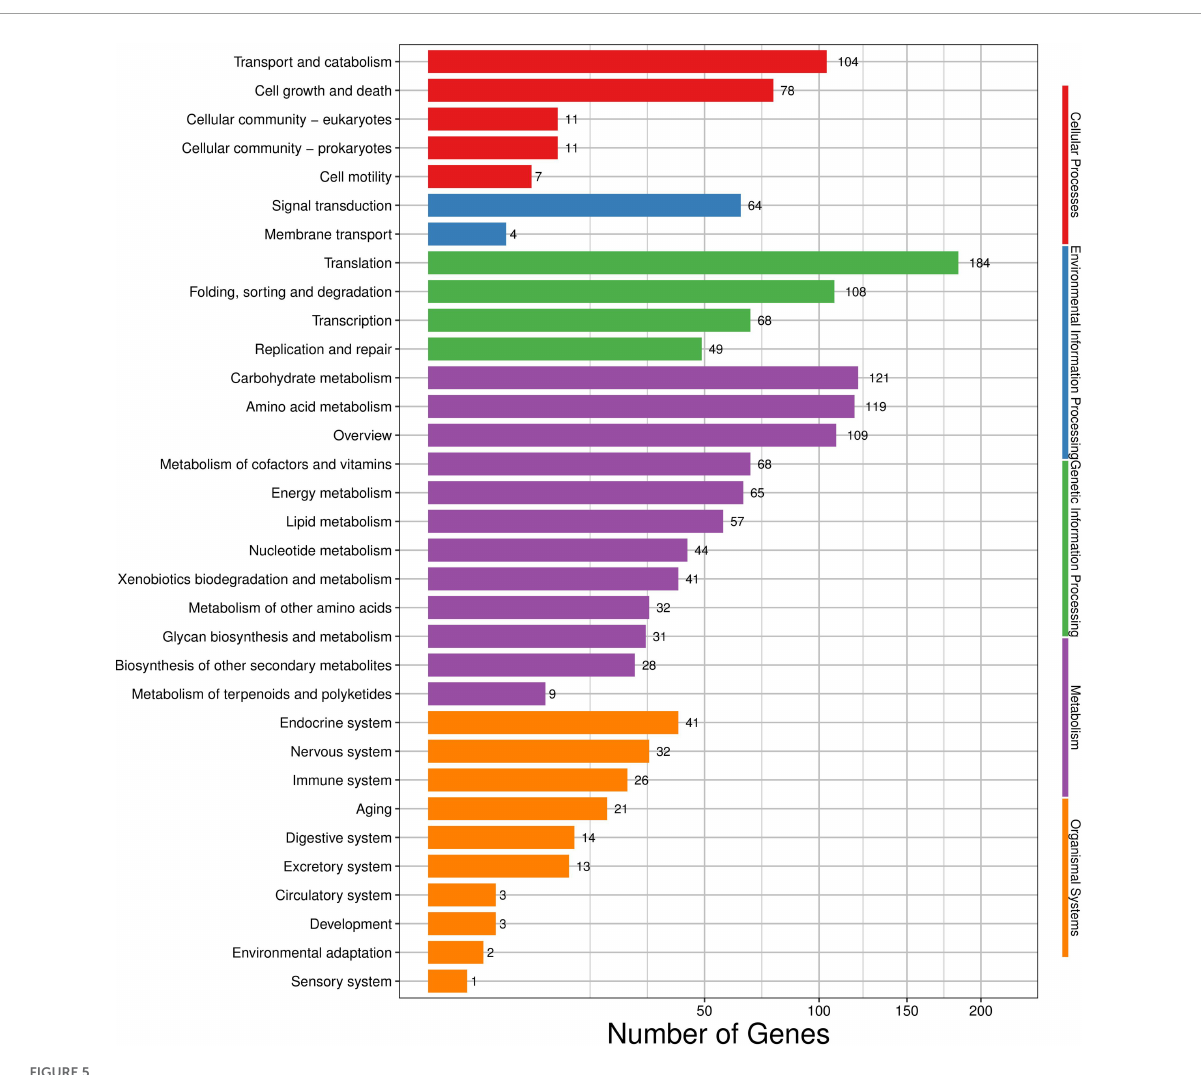
FIGURE5 Kyoto encyclopedia of genes and genomes (KEGG) categories mapped from the annotated proteins. The vertical axis lists the names of pathways in the KEGG database, and the horizontal axis shows the proportion of annotated genes in each pathway.